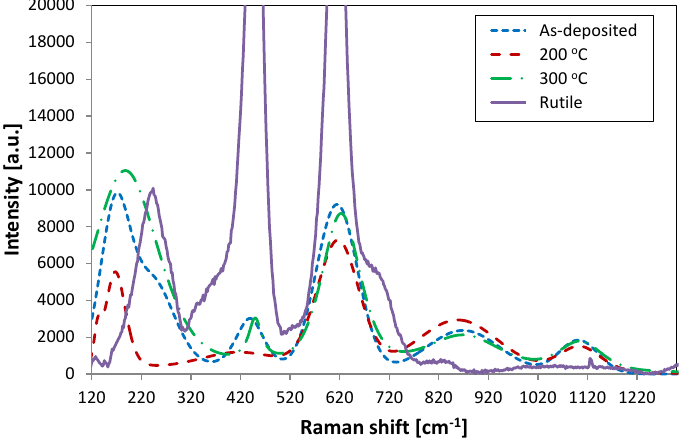
Figure 2. Raman spectra of titania coatings from the as-deposited sample and samples annealed at 200 and 300 °C, aligned with the rutile standard.